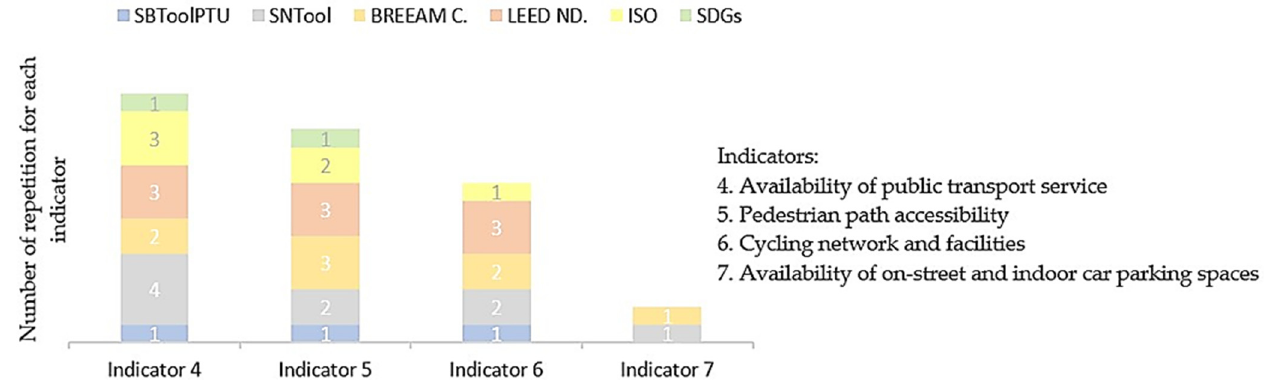
Figure 2. Frequency distribution of each indicator, relevant to the category of transportation infra- structure in SBTool PT _Urban (2018), SNTool Min (2020), BREEAM-C (2012), LEED-ND (2018), ISO 37120 and SDGs.